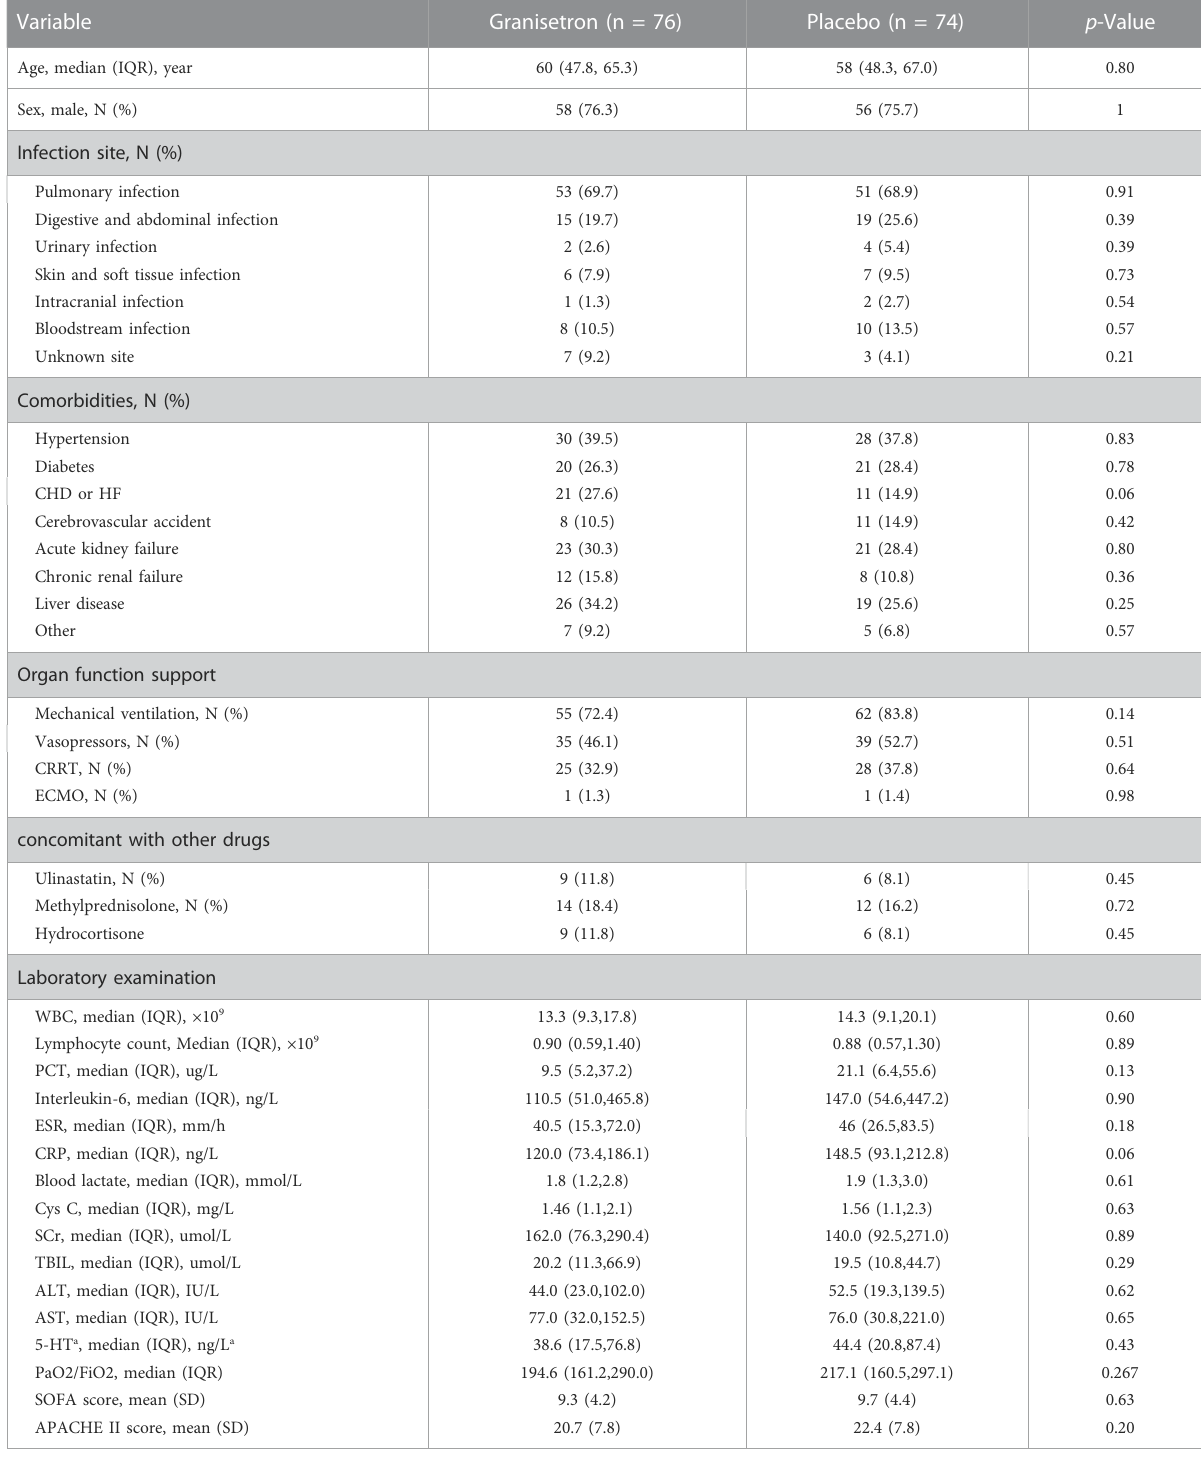
TABLE 1 Clinical characteristics of enrolled patients with